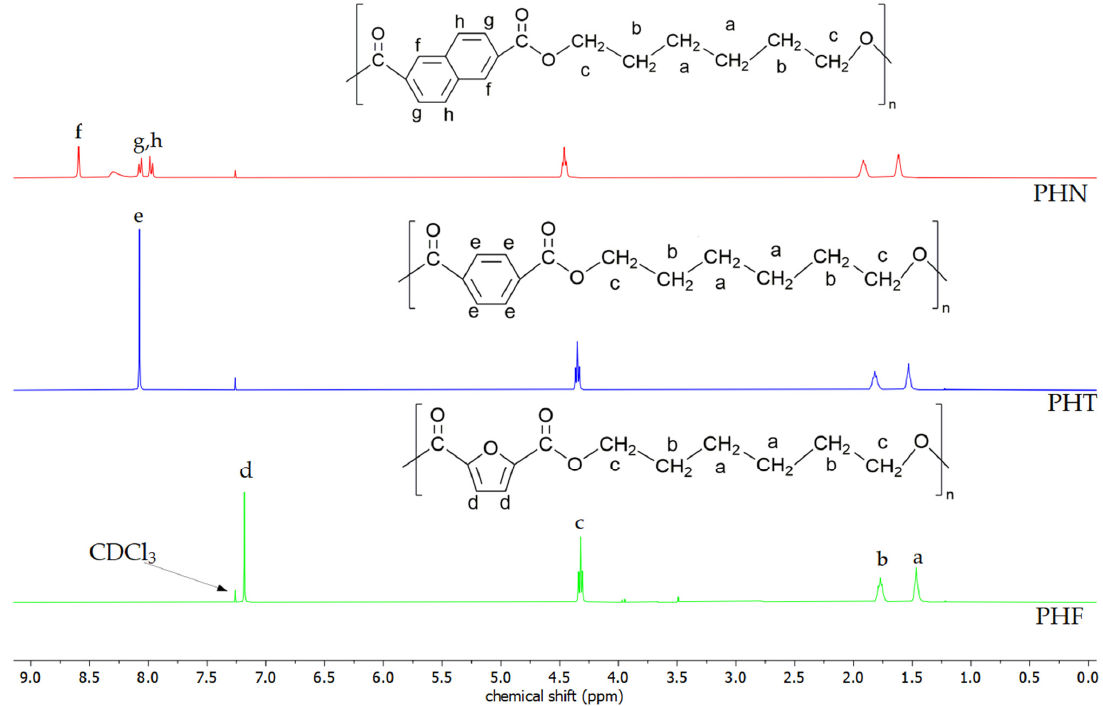
Figure 2. Structure of polyesters and their NMR spectra.